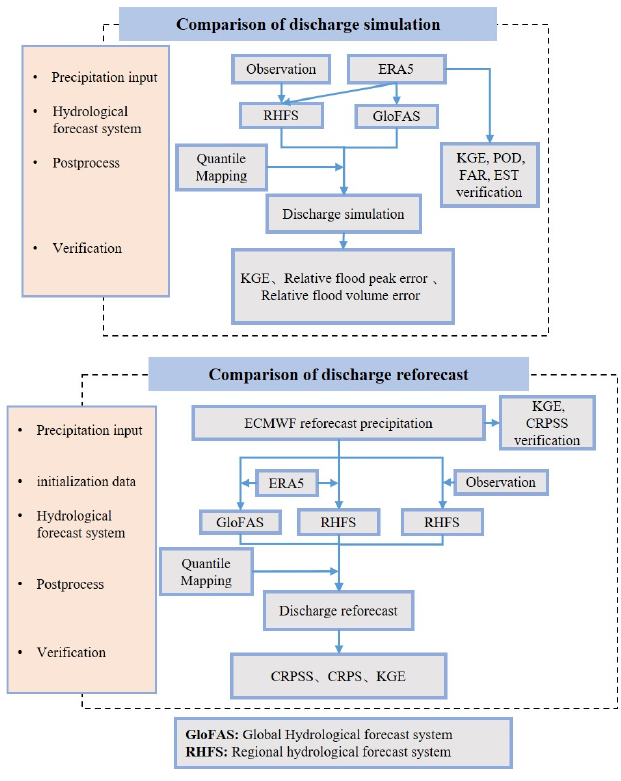
Figure 1. Flow chart of this paper.